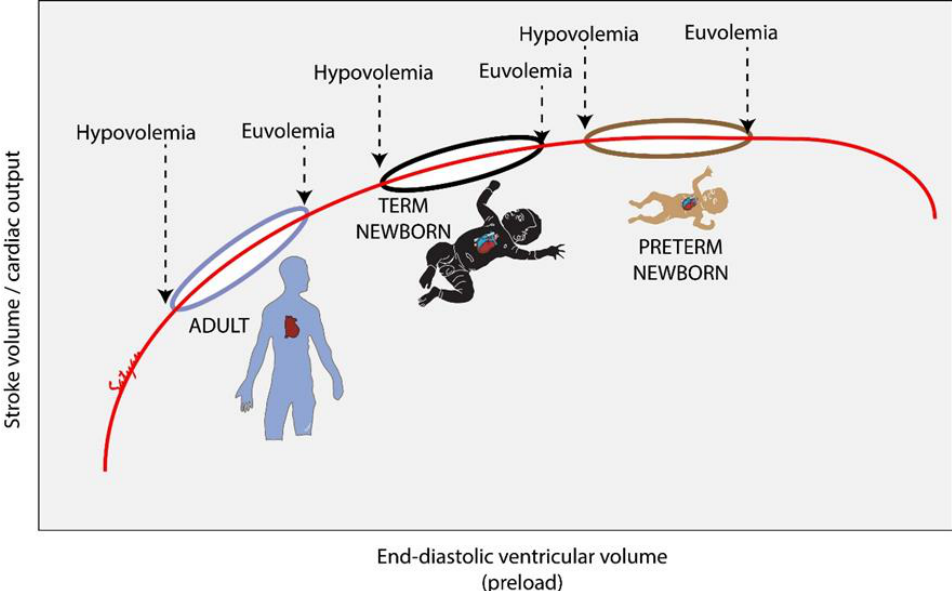
Figure 5. Change in stroke volume/cardiac output with change in end-diastolic ventricular vol- ume (Frank–Starling law) in adults, term and preterm neonates (Adapted with permission